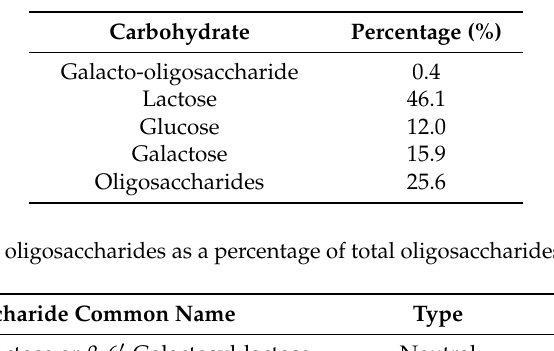
Table 1. The carbohydrate composition, as a percentage of total carbohydrates, of the caprine milk oligosaccharide-enriched fraction (CMOF) obtained after purification. Oligosaccharide content was determined by LC/MS analysis while glucose and galactose content was determined from HPLC analysis.